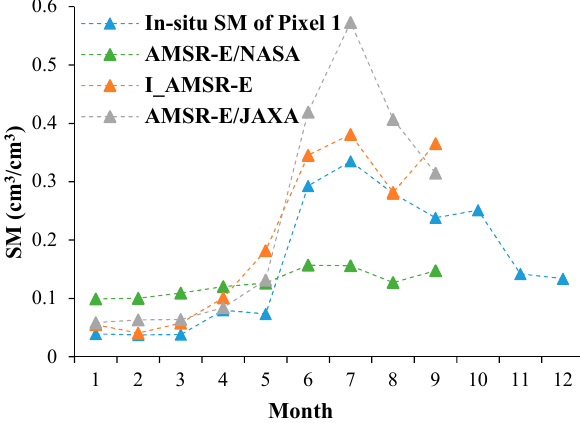
Figure 10. Monthly I_AMSR-E, AMSR-E/NASA and JAXA SM retrievals and in-situ SM measurements in Pixel 1 in the Naqu area of the Tibetan Plateau in 2011.